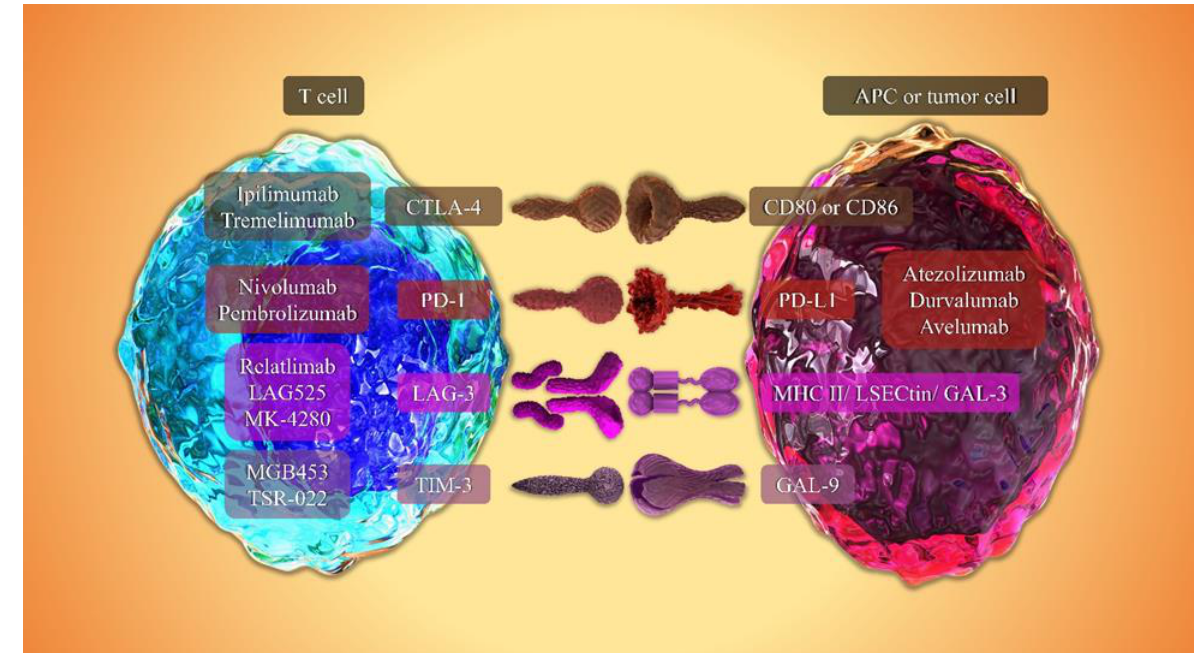
Figure 2. The overview of monoclonal antibodies against immune checkpoints and their ligands. Cytotoxic T lymphocyte antigen 4 (CTLA-4), programmed cell death 1 (PD-1), programmed cell death 1 ligand 1 (PD-L1), lymphocyte-activation gene 3 (LAG-3), T-cell immunoglobulin- and mucin domain-3-containing molecule 3 (TIM-3), LSECtin (liver sinusoidal endothelial cell lectin), galectin-3 (GAL-3), and galectin-9 (GAL-9).